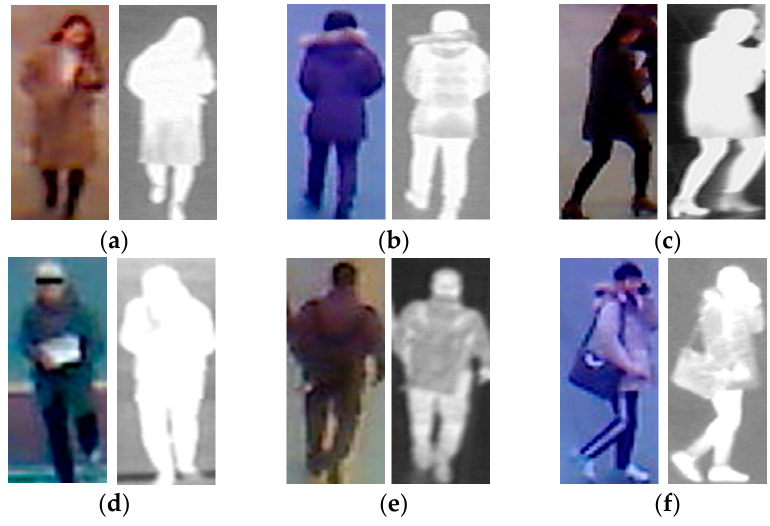
Figure 6. Example of visible light and thermal images in the collected database used in our experiments: ( a – c ) visible light-thermal image pairs of the female class with ( a ) front view; ( b ) back view; and ( c ) side view; ( d – f ) visible light-thermal image pairs of the male class with ( d ) front view; ( e ) back view; and ( f ) side view.